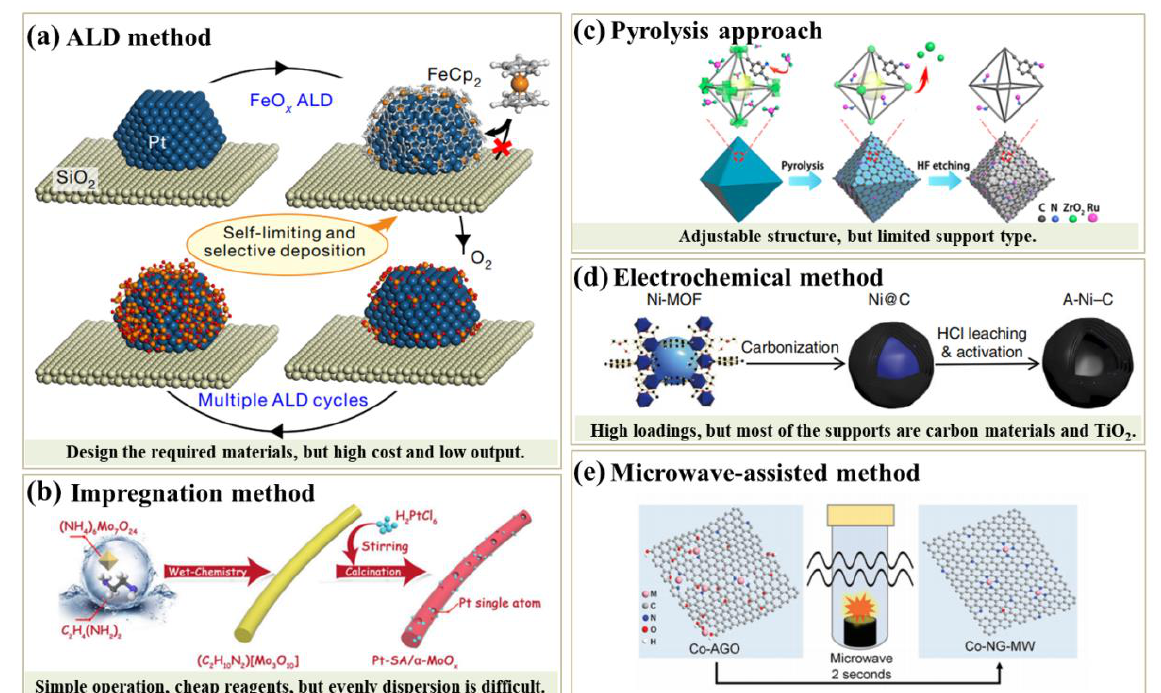
Figure 2. Schematic illustrations of preparing ( a ) FeO x -Pt/SiO 2 by the ALD method . Re- Figure printed/adapted with permission from Ref.[35]. Copyright 2019, copyright Springer Nature Lim- ited, ( b ) Pt-SA/ ɑ -MoO x by the impregnation method. Reprinted/adapted with permission from